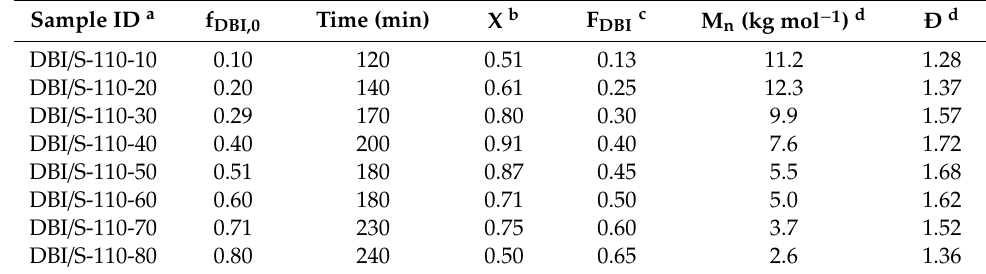
Table 2. Summary of dibutyl itaconate / styrene copolymerizations in 50 wt% dioxane solution at 110 ◦ C.